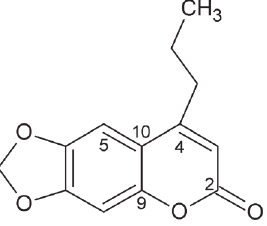
FIGURE 1 - Structure of 8-propyl-6H-[1,3]dioxolo[4,5-g] chromen-6-one